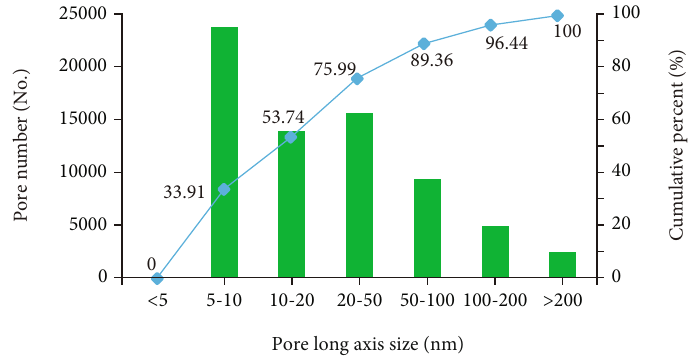
Figure 15: Characteristics of the long axis of organic pores based on 3D FIB-SEM data. The majority of long axes are shorter than 100